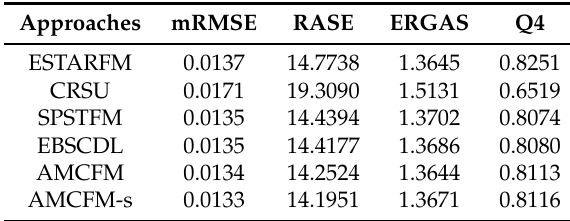
Table 7. Global quality metrics in image 2.